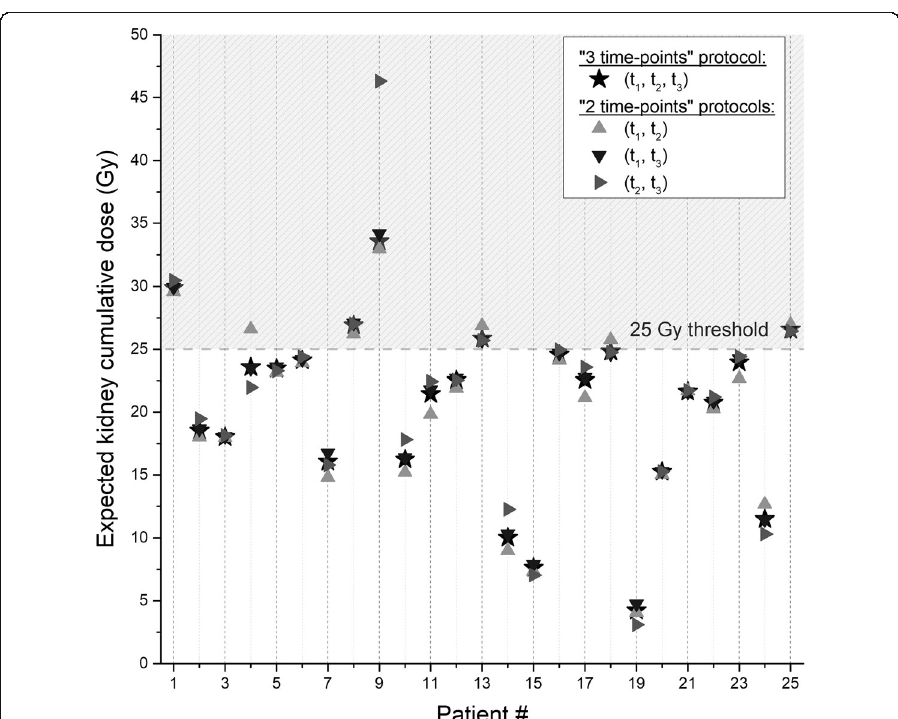
Fig. 2 Expected dose after the last PRRT calculated from the previous ones (1 to 3) using the standard “ 3 time-points ” protocol (black stars) or the different “ 2 time-points ’ protocols (triangles). Each vertical line represents a patient and the dashed region the unsafe dose region and interruption of the treatment (patients # 1, 8, 9, 13, and 25 following the standard